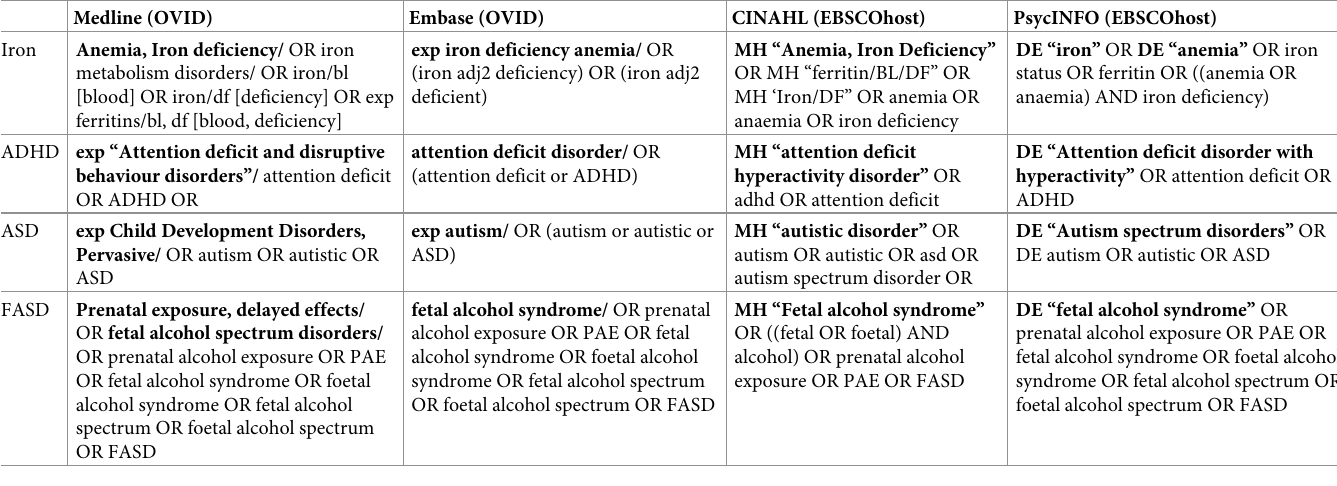
Table 1. Detailed search strategies used in each